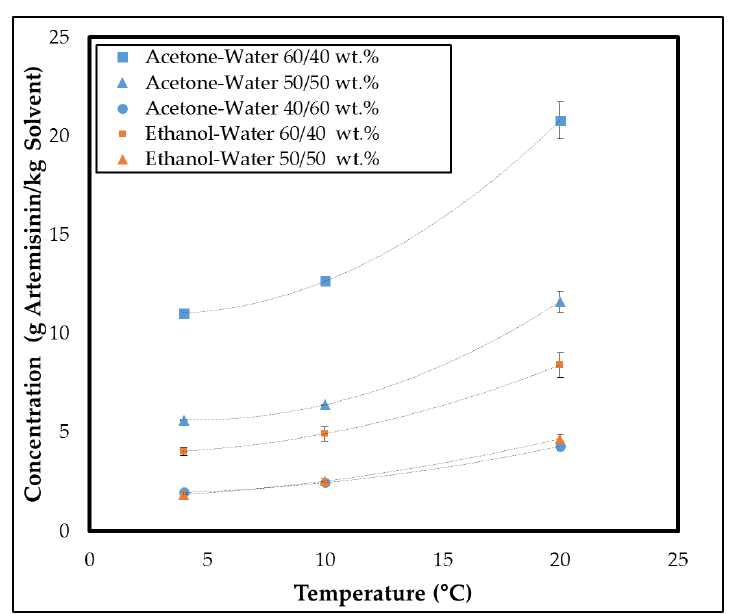
Figure 3. Solubility screening of different acetone-water and ethanol-water mixtures.